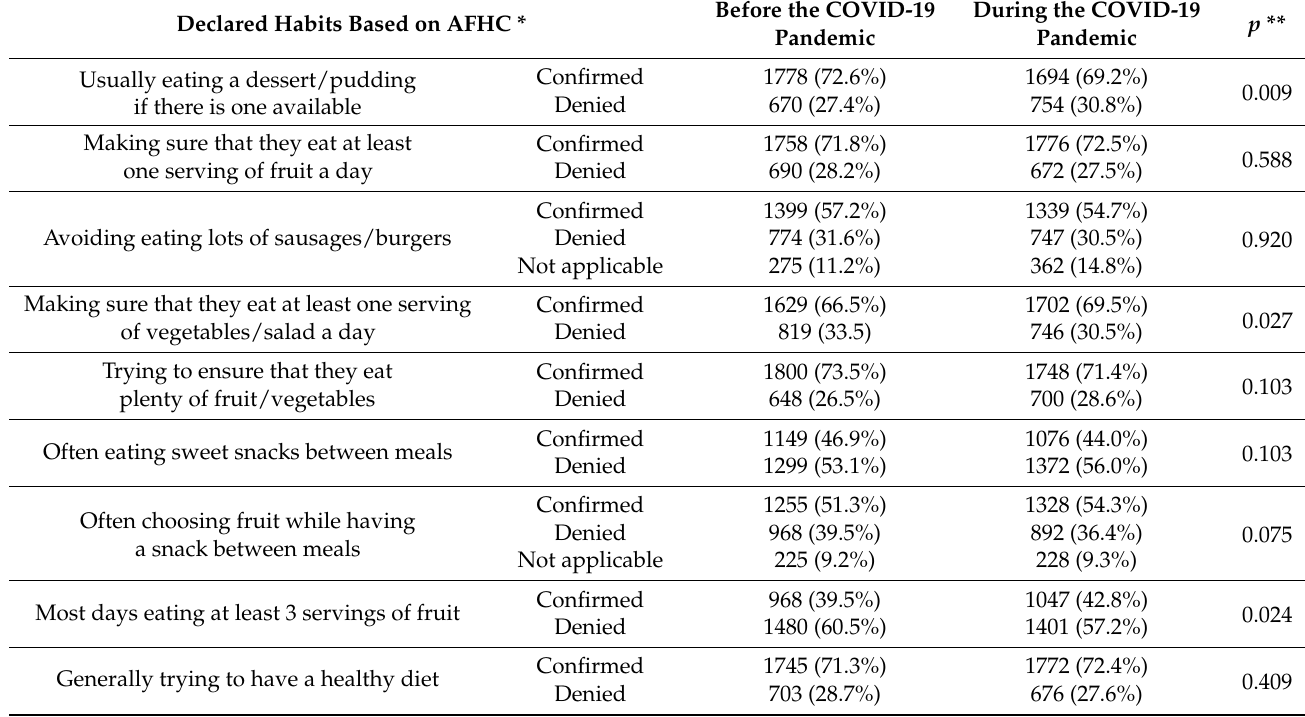
Table 4. The food consumption dietary habits assessed on the basis of the Adolescents’ Food Habits Checklist (AFHC) within the PLACE-19 Study.